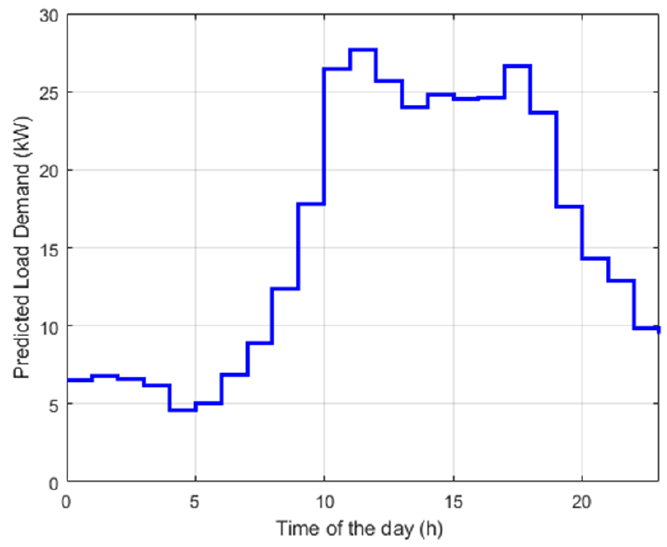
Figure 5. Predicted load demand in the microgrid.